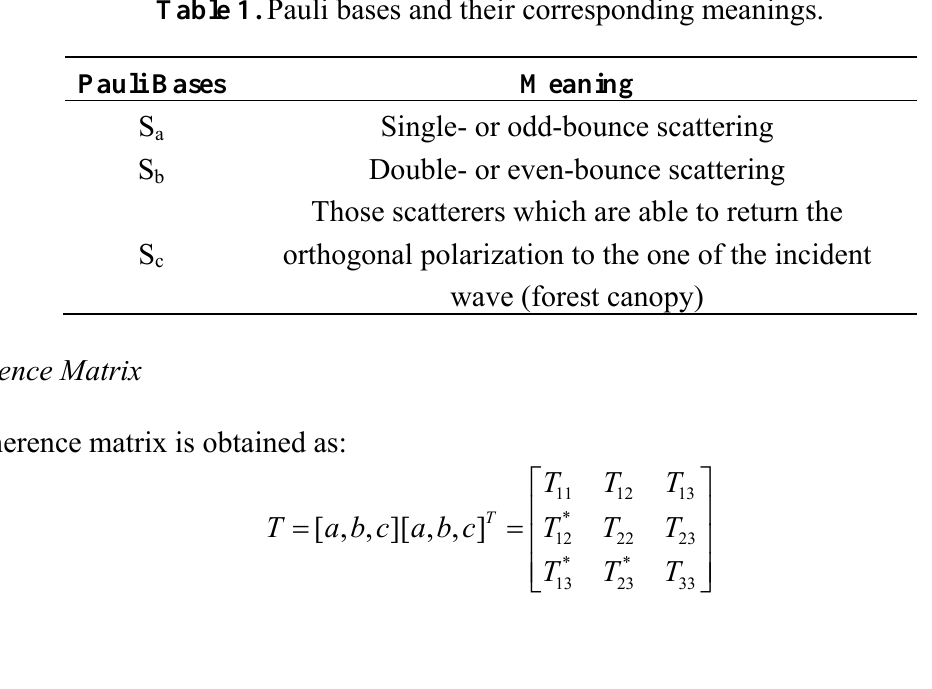
Table 1. Pauli bases and their corresponding